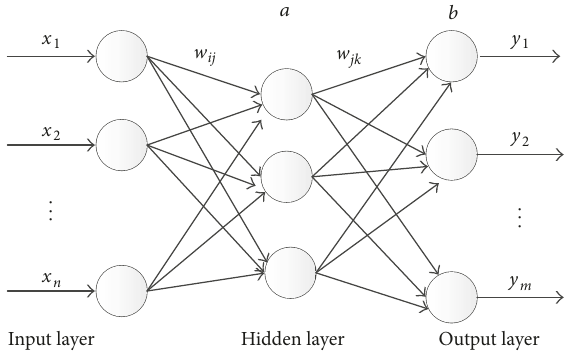
Figure 4: The topological structure of